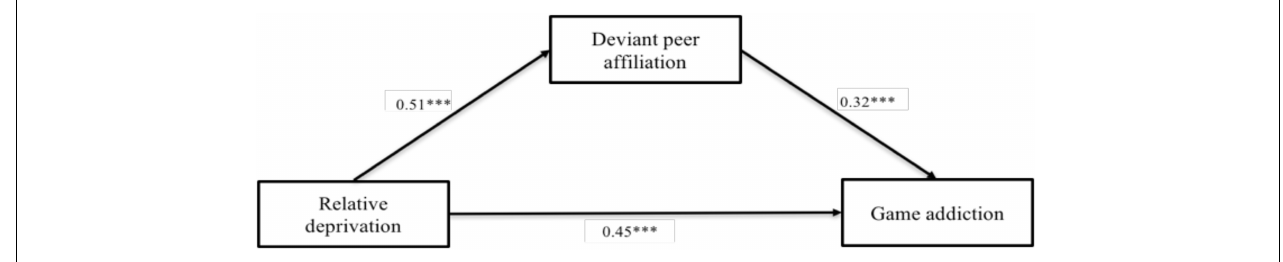
FIGURE 3 | The mediation of deviant peer affiliation. The link between relative deprivation and left-behind children’s game addiction was mediated by deviant peer affiliation. The path values are the path coefficients. Gender, left-behind category and socioeconomic status were controlled during this analysis. ∗∗∗ p < 0.001.